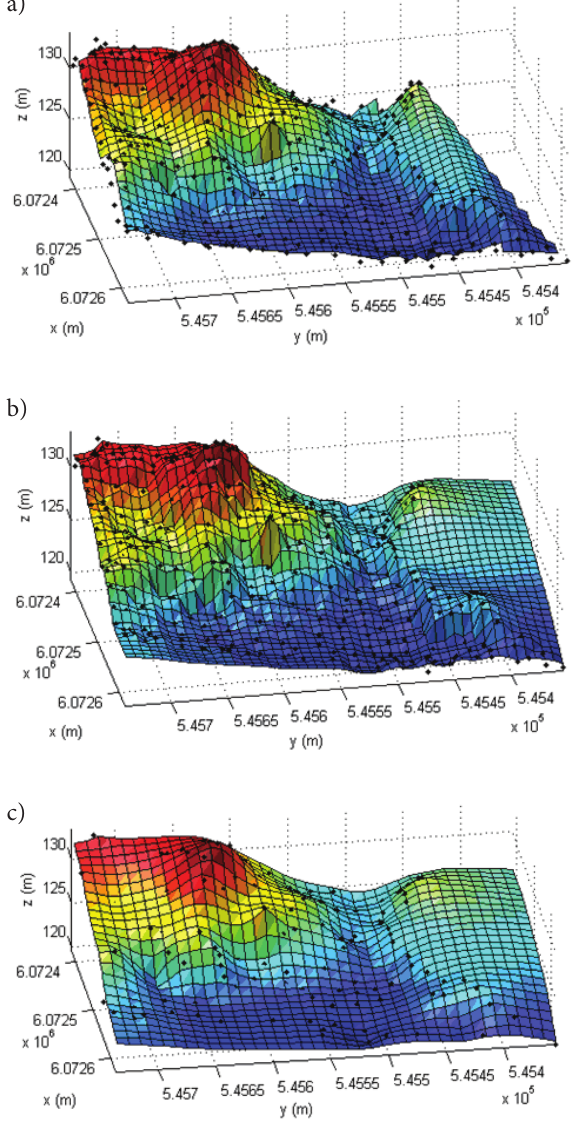
2 pav. Trimačiai paviršiaus modeliai, sukurti taikant skirtingo interpoliavimo algoritmus: a) tiesinio, b) svorinio, c) Kriging Fig. 2. Three-dimensional surface models created using different interpolation algorithms: a) linear, b) inverse distance weighted, c)